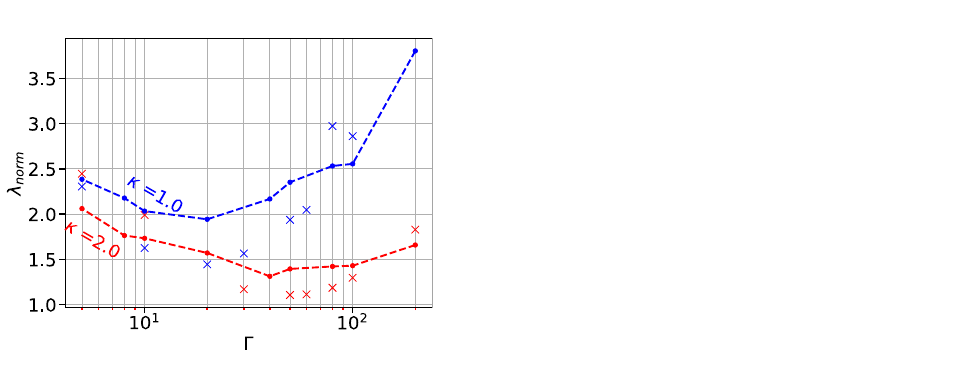
Figure 8. Comparison of heat conductivity calculated with NEMD Method (dashed lines), and the present work using Eq. (19). The thermal conductivity is normalized with ω p as (cid:31) norm